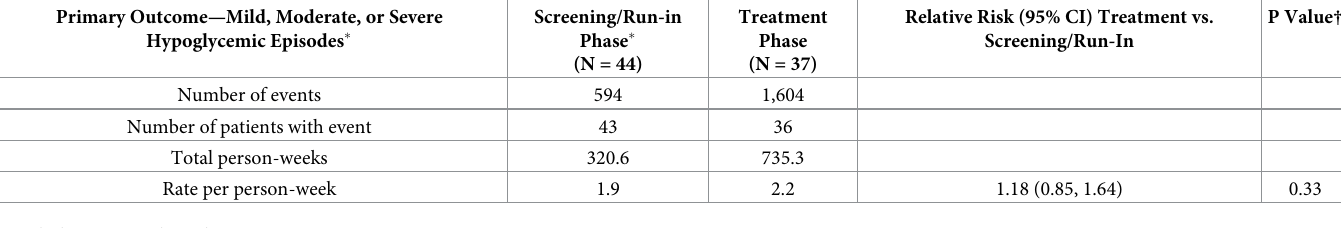
Table 2. Primary safety outcome during screening/run-in vs. treatment phases—Weekly combined mild, moderate, and severe hypoglycemic episodes. Primary Outcome—Mild, Moderate, or Severe Hypoglycemic Episodes (cid:3)